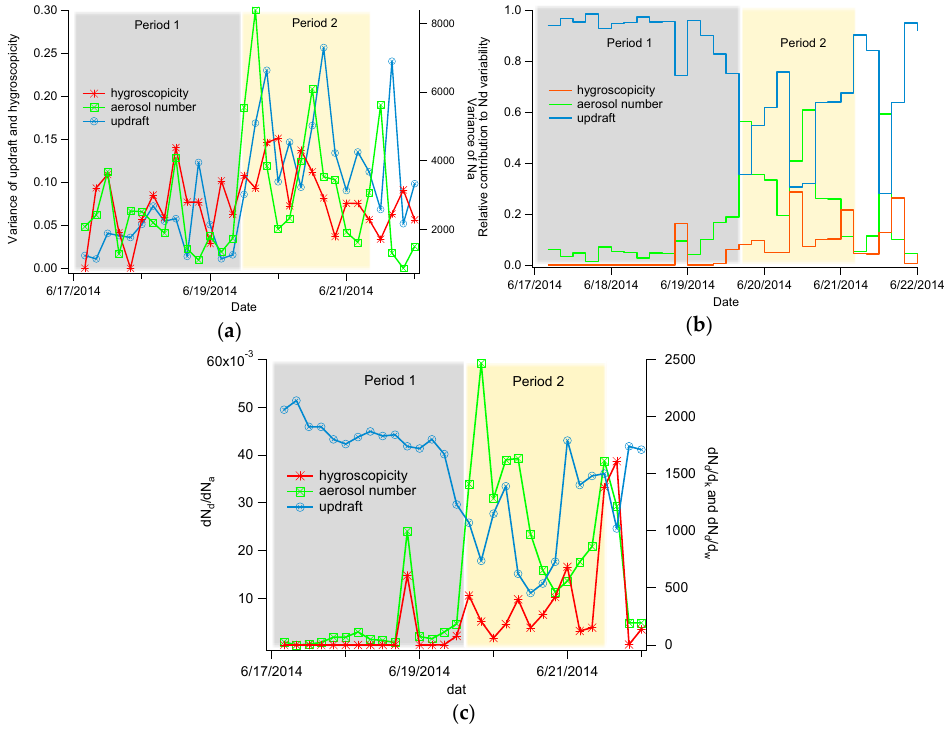
Figure 4. Timeseries of the different estimated parameters that contribute to the droplet formation: ( a ) variance of updraft, hygroscopicity and aerosol number, ( b ) attribution of N d variability to N a , κ , and w , and ( c ) sensitivity of N d to N a , κ and w from the droplet parameterization. The s max levels computed for each period provide conclusions that are consistent with remote sensing observations. The EOLE Raman lidar (1064 nm) for Period 1 did not detect the formation of any clouds (Figure 5a), consistent with the extremely low values of s max and vertical velocity that would develop in any cloudy parcels. The absence of any clouds and the specific conditions during each period are also presented in detail by Papayannis et al. [18]. On Jun 20, EOLE detected a deep PBL, updraft velocities were considerably higher, especially during early morning hours, and RH levels were much higher than during Period 1. These meteorological conditions are more favorable for the formation of clouds, which was detected by the Raman lidar on the top of the PBL during early morning (Figure 4b), and even lead to a limited precipitation event after local noon. For that day, the higher maximum supersaturation led to estimated droplet numbers that were three-fold higher, compared to those on June 18.